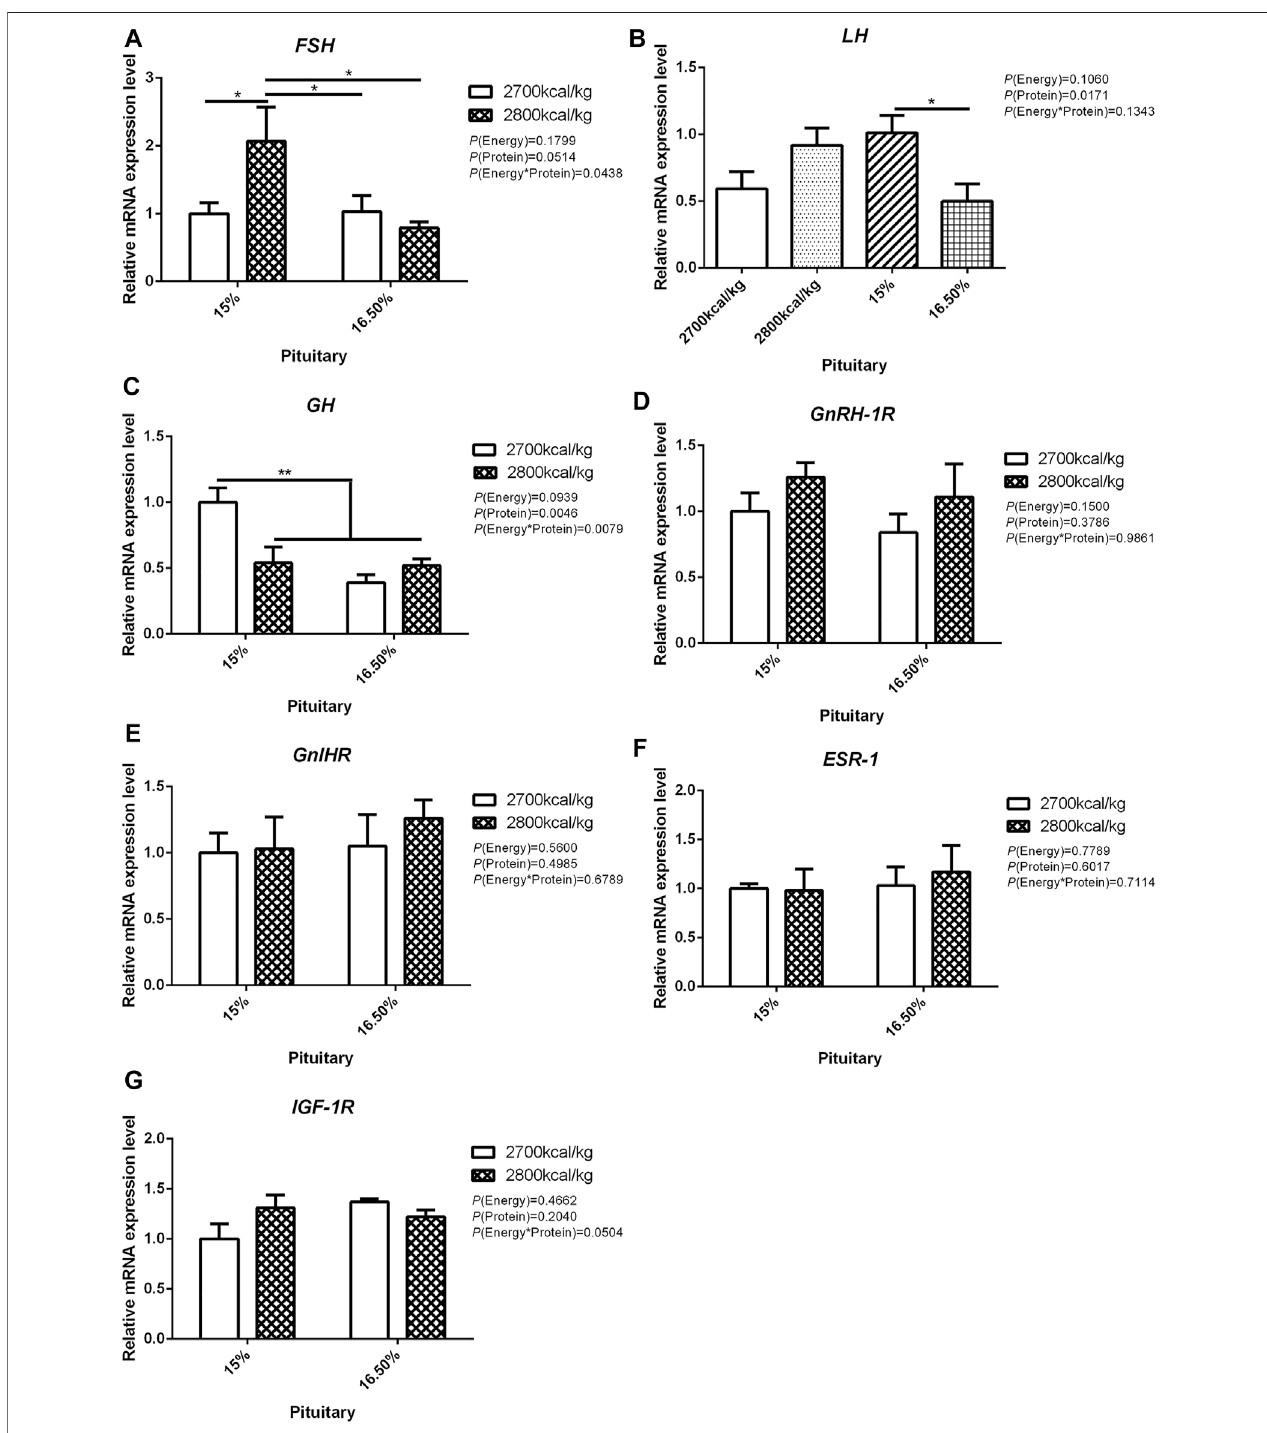
FIGURE2 | Effect of dietary metabolizable energy (E) and crude protein (P) levels during the prelay period (15 – 20 weeks of age) on themRNA expression of genes FSH (A) , LH (B) , GH (C) , GnRH-1R (D) , GnIHR (E) , ESR-1 (F) , and IGF-1R (G) in the pituitary of hens. Data represent the mean ± SD ( n = 4); p p < 0.05, pp p < 0.01.